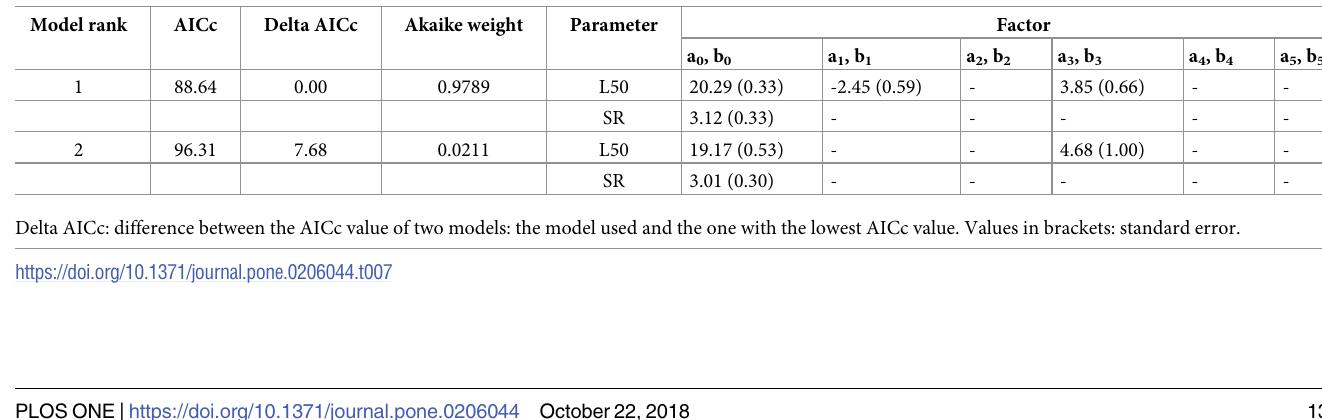
NT: number of individuals counted in the codend; qNT: codend sampling ratio; NC: number of individuals counted in the codend cover; qNC: codend cover sampling ratio; L50: 50% retention length; SR: selection range (L75-L25); CI: confidence intervals; DOF: degrees of freedom.